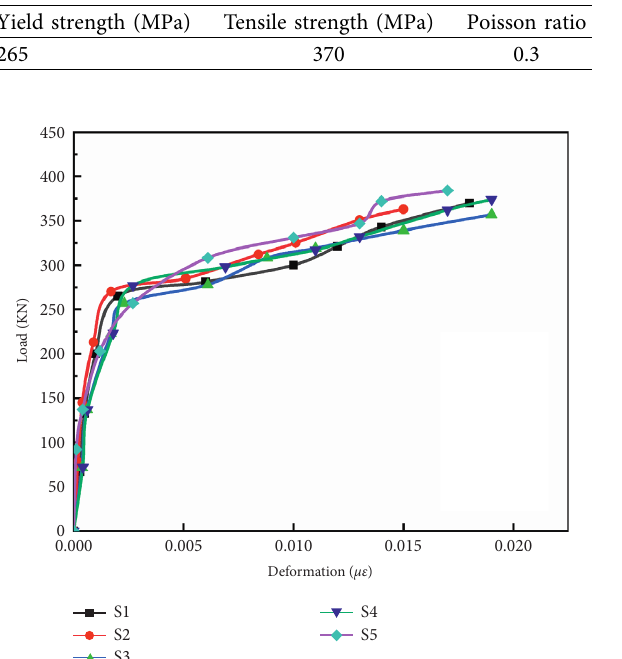
Figure 5: Stress-deformation curve of steel.